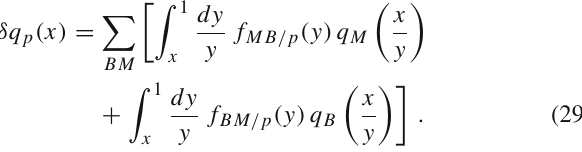
Thesplittingfunctions f BM / p ( y ) and f MB / p ( y ) aretheprob- ability of the Fock state containing a virtual baryon (B)